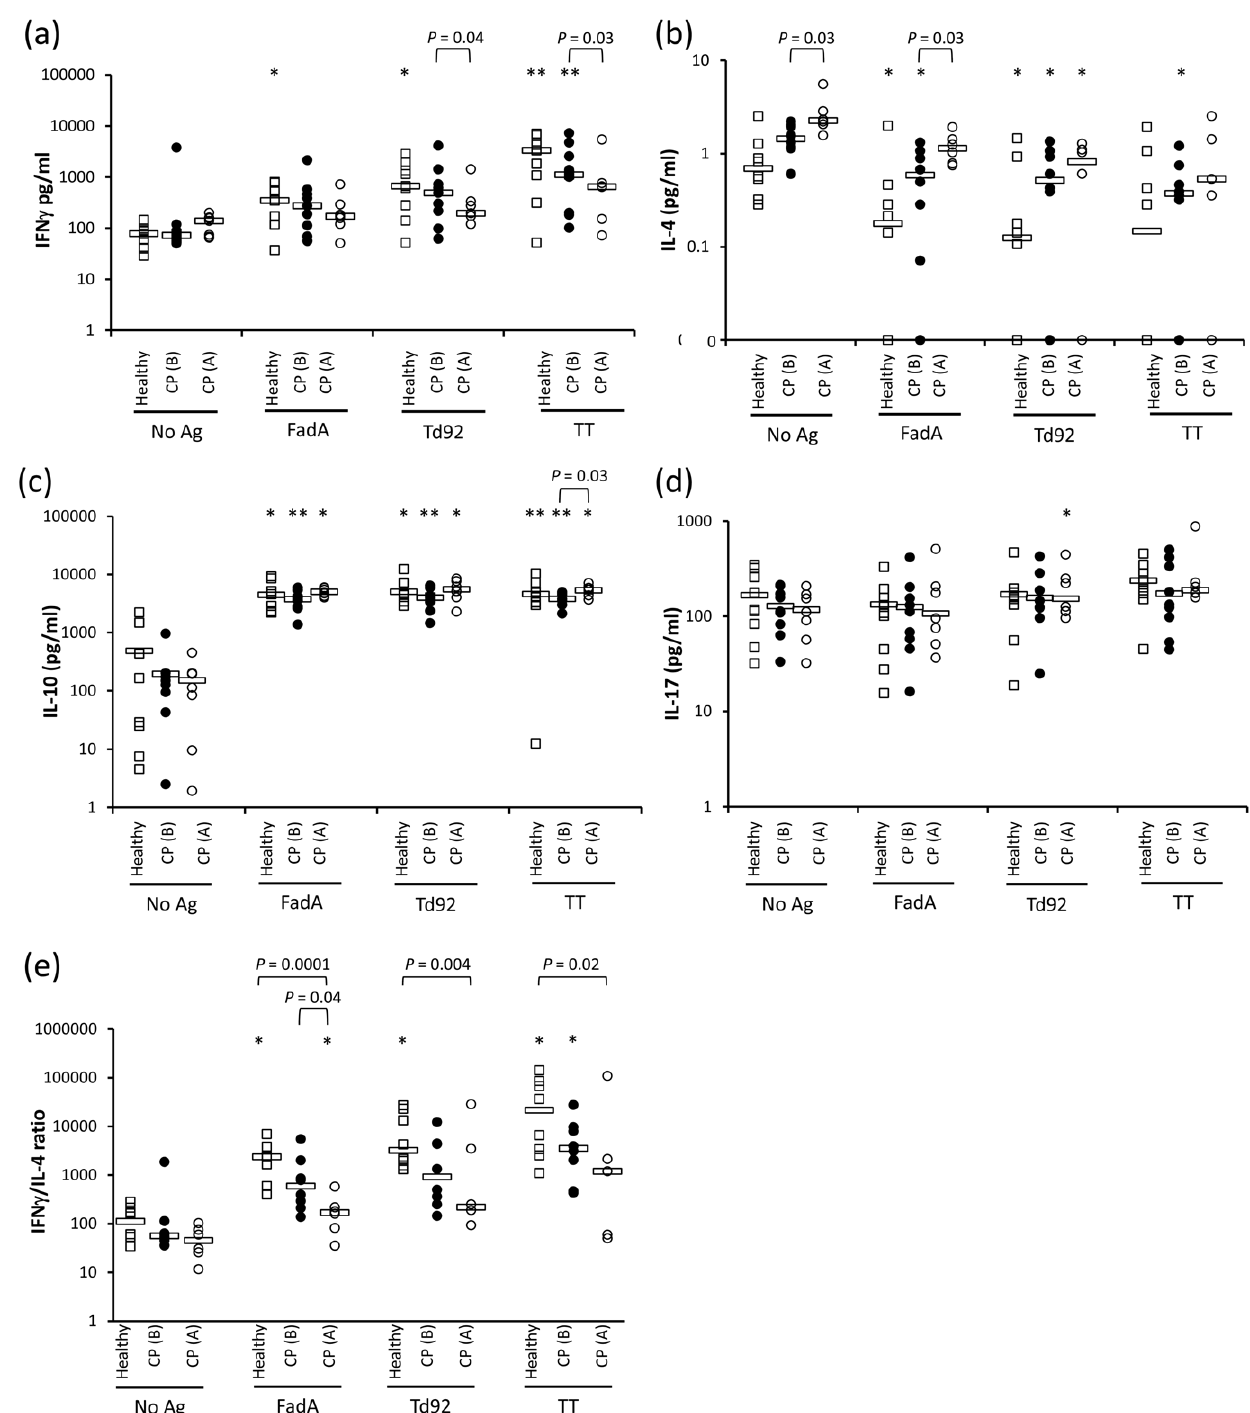
Figure 3. Cytokine production by PBMCs in response to FadA, Td92, or TT PBMCs from healthy subjects (n=9), patients with CP before (B) treatment (n=9), and patients with CP after (A) treatment (n=7) were stimulated with medium alone (No Ag), 30 m g/ml FadA, Td92, or TT for 48 hours in the presence of purified anti-CD28 mAb and anti-CD49d mAb. (a–d) The amount of IFN c , IL-4, IL-10, and IL-17 secreted into the supernatant was measured by ELISA. (e) The ratio of IFN c /IL-4 was calculated and plotted. For the calculation of this ratio, half of the lowest detectable concentration (0.1 pg/ml) was arbitrarily assigned to IL-4 samples that had a zero value. Bars indicate median values. *, P , 0.05; **, P , 0.01 compared to No Ag.